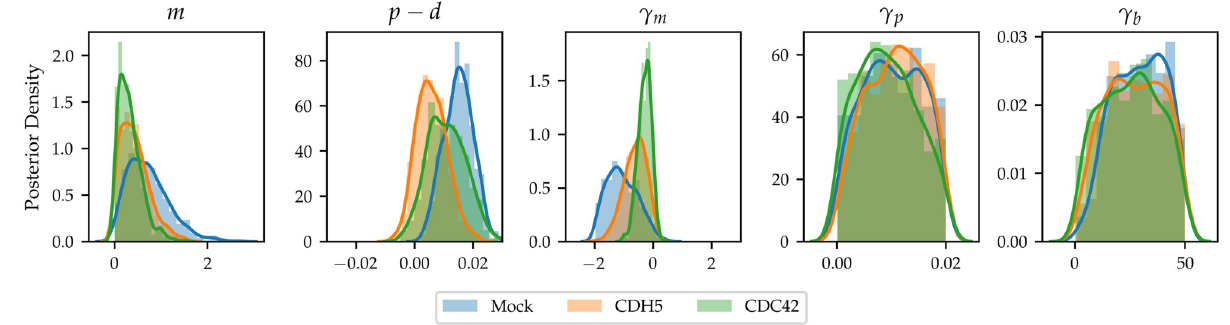
Fig 4. Posterior distributions for three genetic perturbations with large numbers of observations. Blue: Mock condition, orange: CDH5 knockdown, green: CDC42 knockdown.